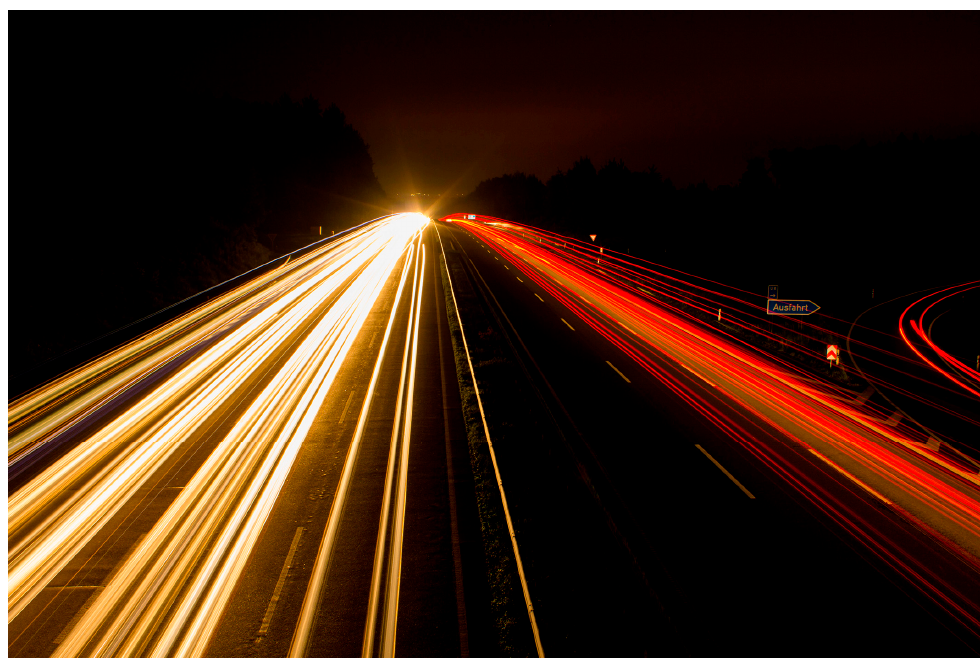
Figure 11. Concept of the project: road light